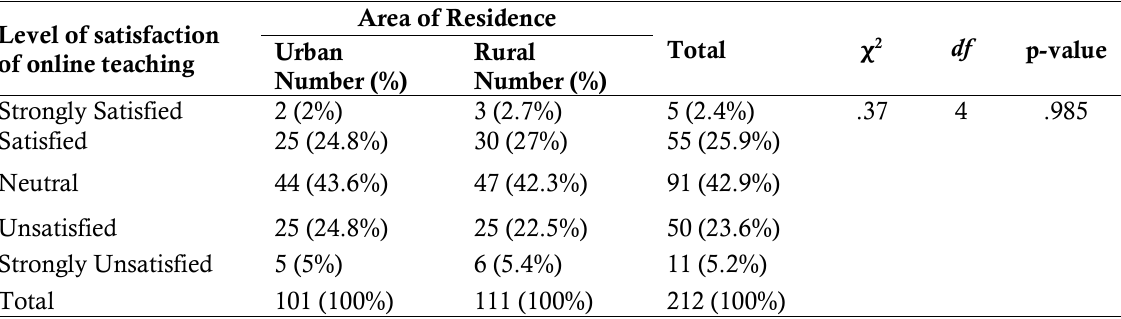
Table 4 <Comparison of Satisfaction Towards Online Classes Among Urban and Rural Areas